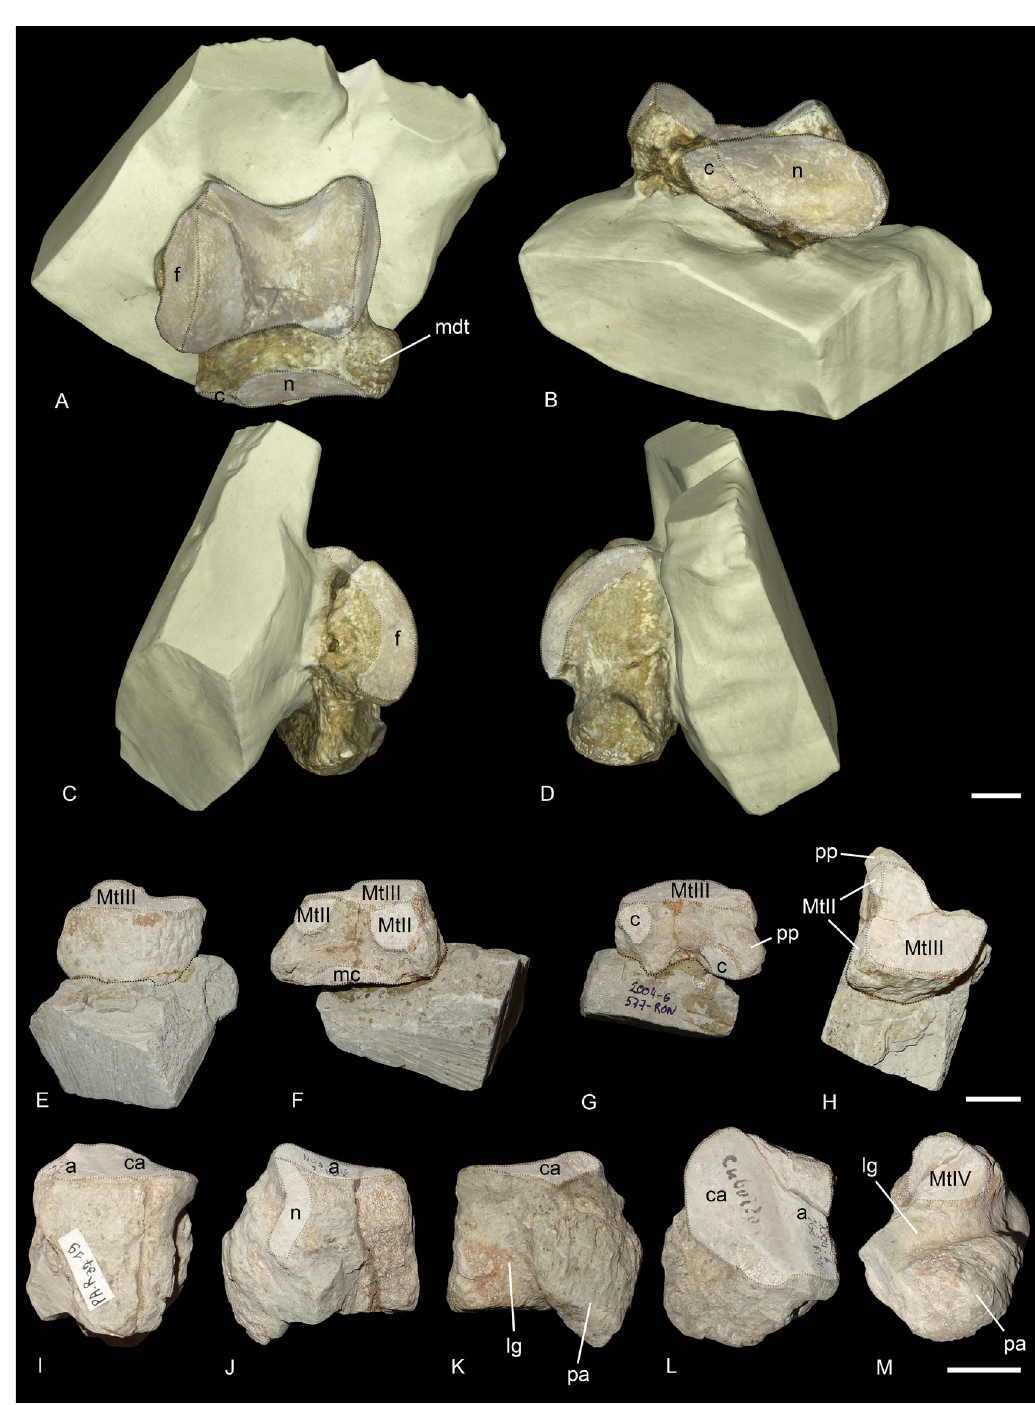
Fig. 7. Ronzotherium velaunum (Aymard in Pictet, 1853) from Ronzon (earliest Oligocene, France). – A–D . Right astragalus PUY.2004.6.1770.RON. A . Anterior view. B . Distal view. C . Lateral view. D . Medial view. – E–H . Right ectocuneiform PUY.2004.6.577.RON. E . Anterior view. F . Medial view. G . Posterior view. H . With distal border towards the top, and distal view. – I–M . Left cuboid PUY.2004.6.268.RON. I . Anterior view. J . Medial view. K . Lateral view. L . Proximal view. M . Distal view. Abbreviations: a = astragalus; c = cuboid; ca = calcaneus; f = fibula; lg = lateral groove; mc = mesocuneiform; mdt = medio-distal tubercle; n = navicular; pa = posterior apophysis; pp = posterolateral process. Articular surfaces highlighted in white. Scale bars: 2